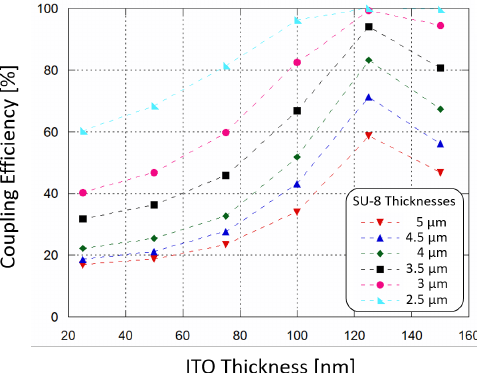
Figure 3. Simulated waveguide-photodiode coupling efficiency as a function of ITO top contact thickness, varying the SU-8 polymer thickness in which light is